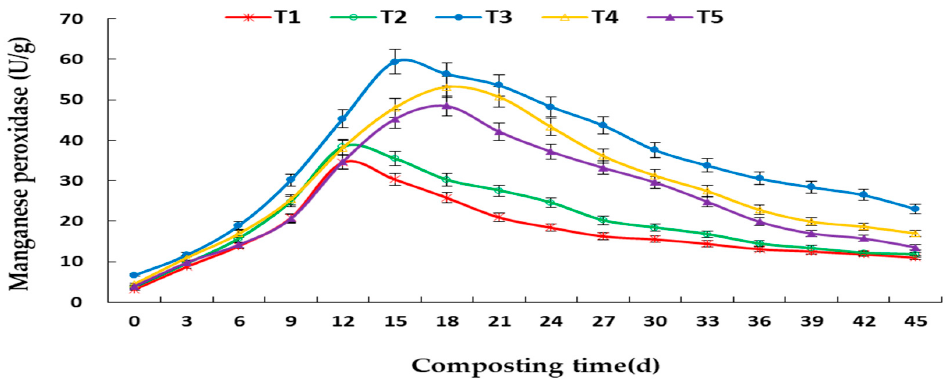
Figure 8. Changes of manganese peroxidase activity during composting of corn straw and cow dung under different C/N ratios.